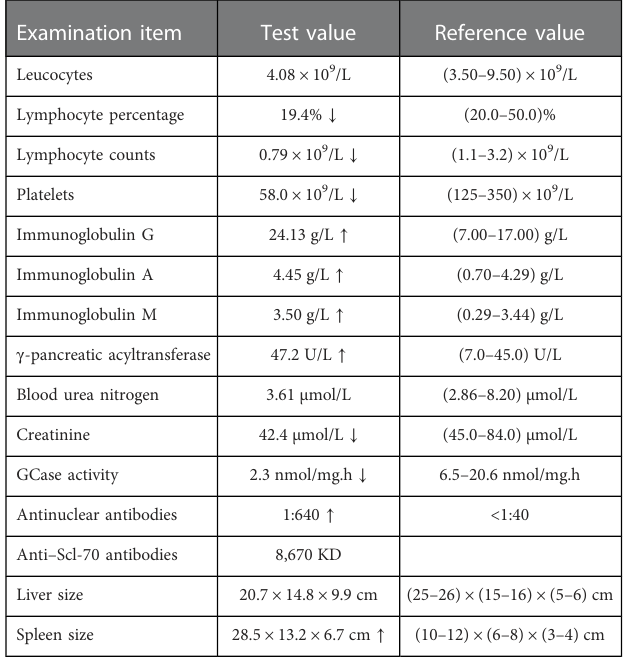
TABLE 1 Physical examination results of the patient.